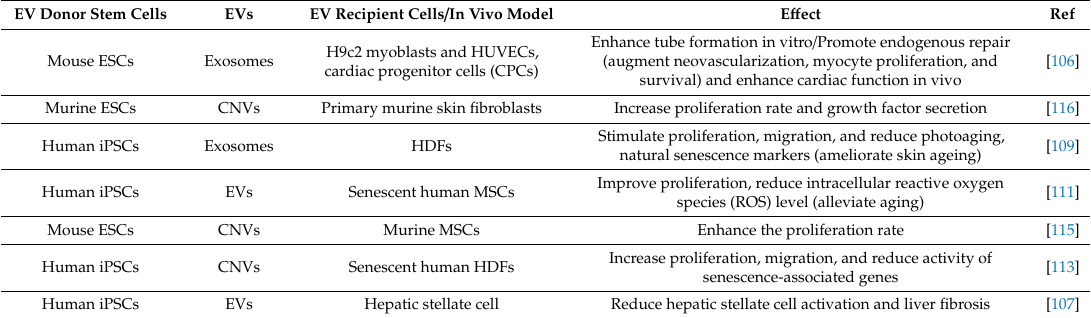
Figure 3. Purification of nano-sized vesicles. Nano-sized vesicles can be purified by precipitation, ultracentrifugation, or density-gradient ultracentrifugation methods. Prior to ultracentrifugation, cells and cell debris must be removed. Density gradient ultracentrifugation is superior to ultracentrifugation and precipitation methods in terms of purity. Table 3. E ff ect of pluripotent stem cell-derived EVs according to recipient cells or in vivo model. EV Donor Stem